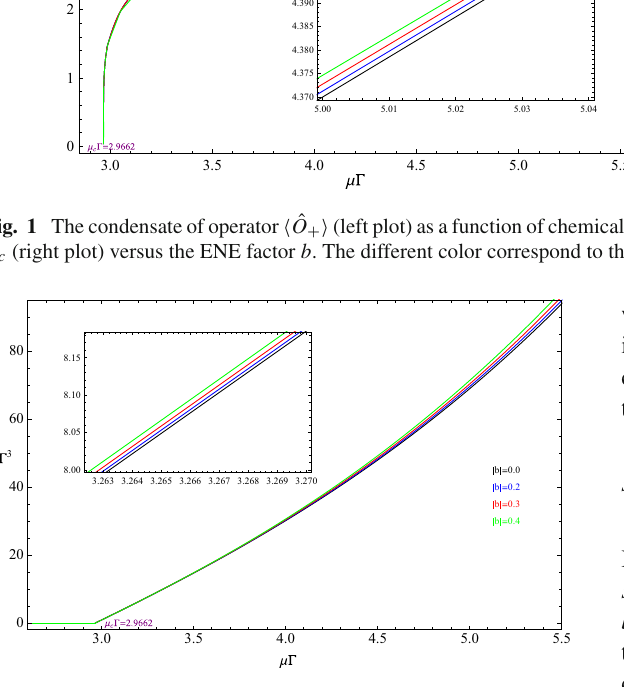
Fig. 2 The charge density ρ as a function of chemical potential μ for different parameter b , respectively. The enlarged view in the red elliptic region is plotted in the right panel. The different color correspond to the different value of parameter